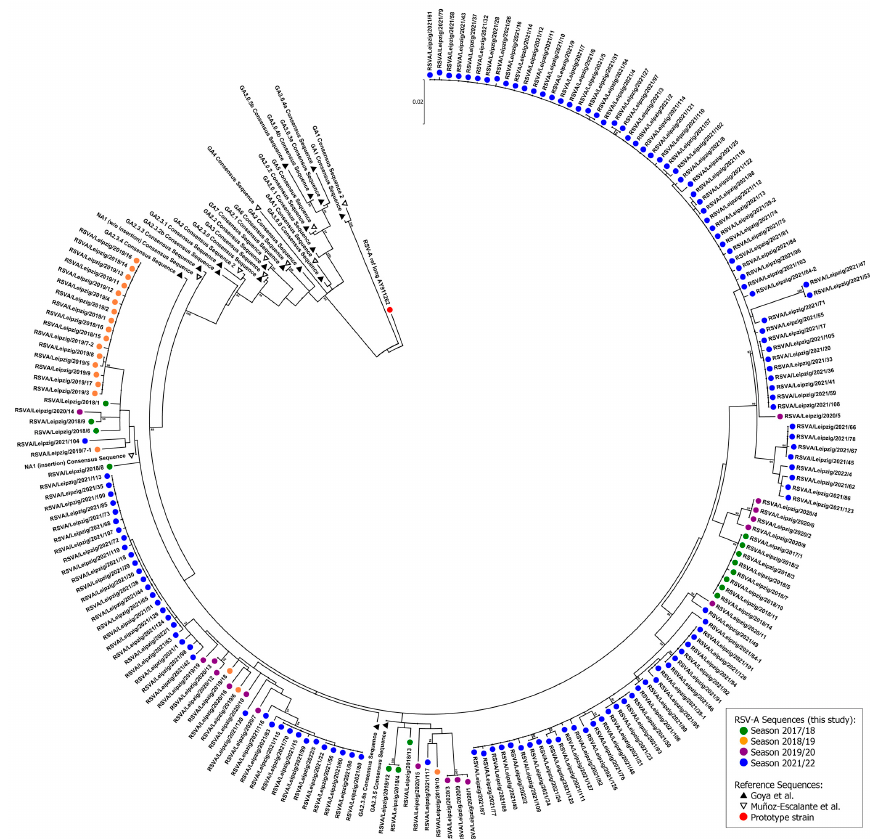
Figure 4. Molecular phylogenetic analysis of the RSV-A G gene by maximum likelihood method. The evolutionary history was inferred by using the maximum likelihood method based on the Tamura– Nei model [24]. The tree with the highest log likelihood ( − 6313.50) is shown. Initial tree(s) for the heuristic search were obtained automatically by applying neighbor-joining and BioNJ algorithms to a matrix of pairwise distances estimated using the maximum composite likelihood (MCL) approach, and then selecting the topology with superior log likelihood value. The tree is drawn to scale, with branch lengths measured in the number of substitutions per site. The analysis involved 214 nucleotide sequences. There were a total of 966 positions in the final dataset. Evolutionary analyses were conducted in MEGA7 [23]. Only nodes with a statistical support >80% are shown. The symbols indicate the sequence origin or the season of the indicated strain (dots: red, RSV-A reference strain; green: season 2017/2018 isolates; orange, season 2018/2019 isolates; purple, season 2019/2020 isolates; blue, season 2021/2022 isolates; black triangle: consensus reference sequences according to Goya et al. [14]; white triangle, consensus reference sequences according to Muñoz-Escalante et al. [16]).